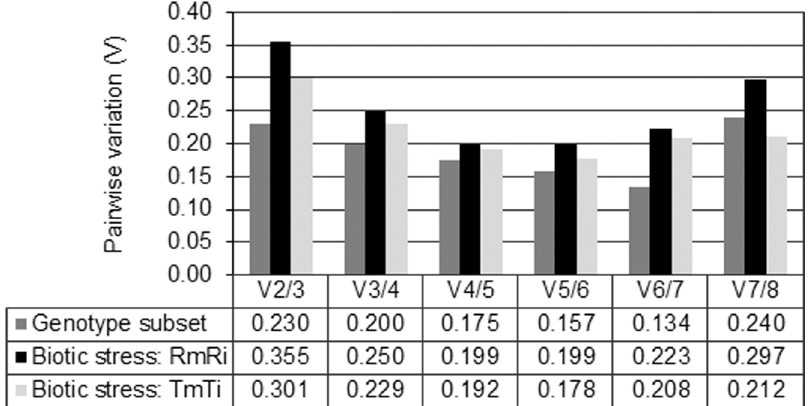
Figure 2. Pairwise variation (V) of candidate genes as predicted by GeNorm. The pairwise variation (Vn/Vn + 1) was calculated between the normalization factors NFn and NFn + 1. Each pairwise variation value is compared with a recommended cut-off value 0.15, below which the inclusion of an additional reference gene is not required.